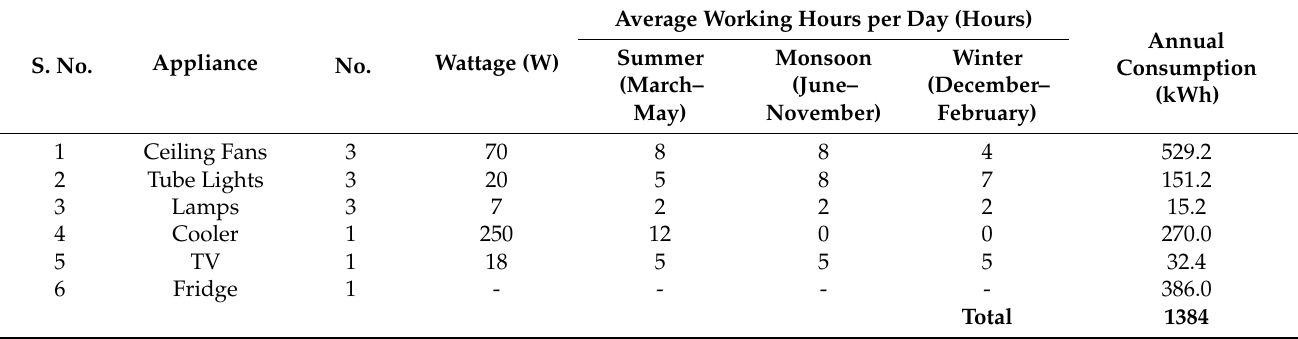
Table 6. Energy usage by a common household over the year.